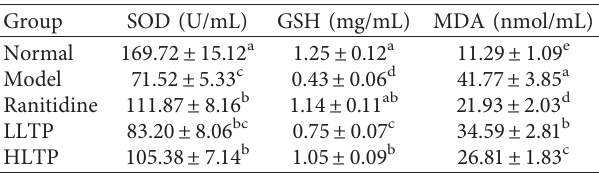
different ( p < 0 . 05) according to Duncan’s new MRT. Ranitidine group: 50mg/kg b.w. ranitidine treatment dose; LLTP group: 100mg/kg b.w. Liupao tea polyphenols dose; and HLTP group: 200mg/kg b.w. Liupao tea polyphenols